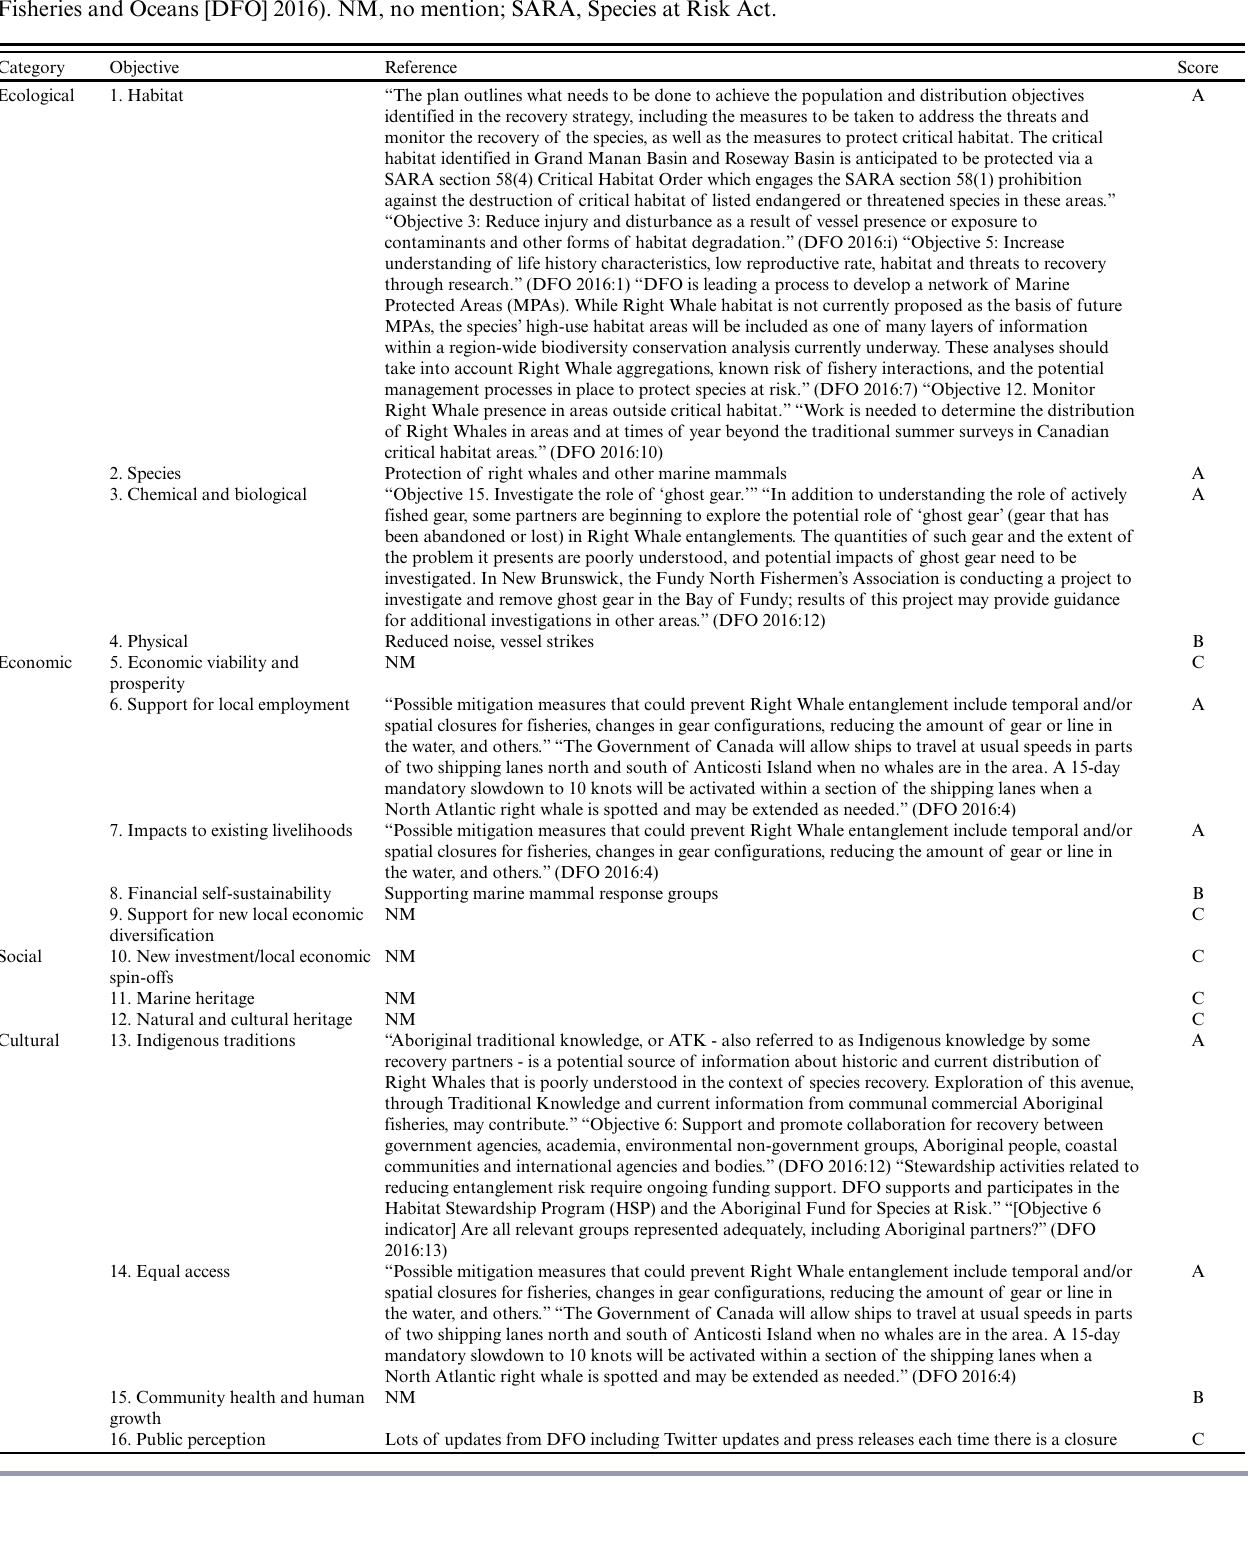
Table 5 ; Desktop Community Values Criteria evaluation of the 2016 Action Plan for the North Atlantic Right Whale (Department of Fisheries and Oceans [DFO] 2016). NM, no mention; SARA, Species at Risk Act. Category Objective Reference Score